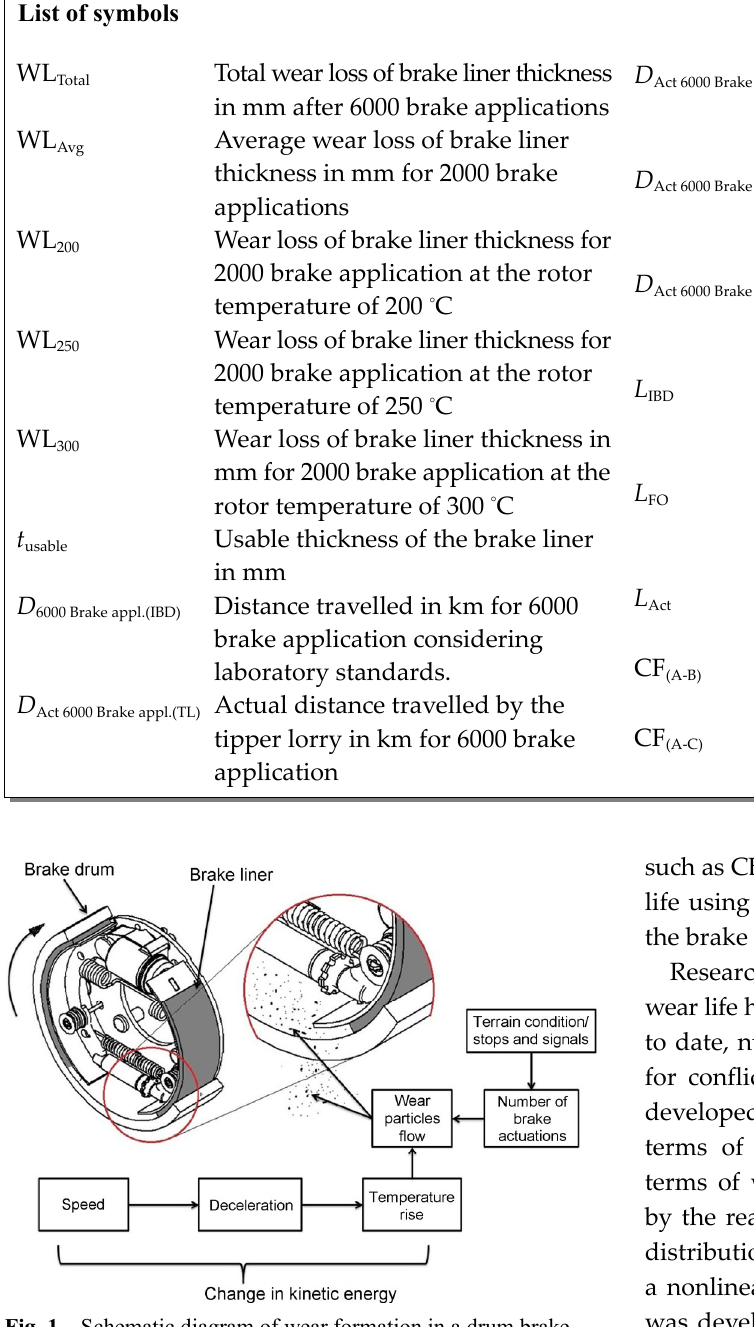
Fig. 1 Schematic diagram of wear formation in a drum